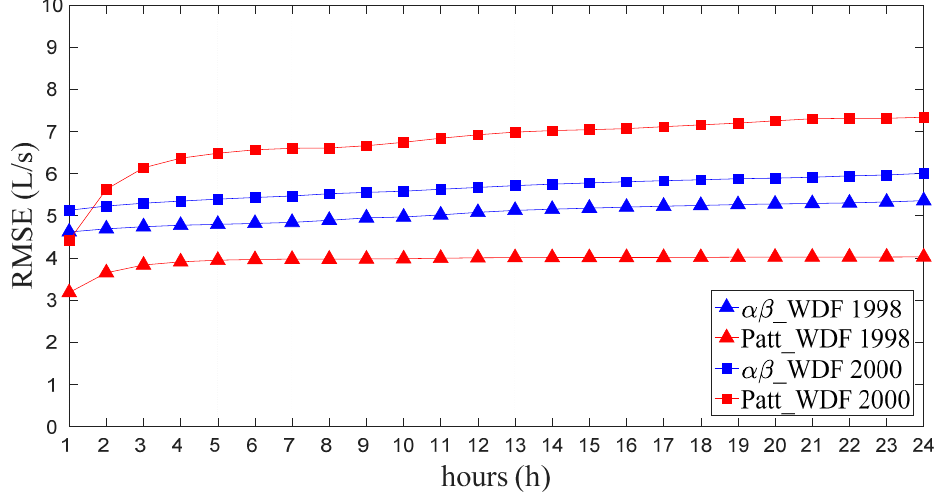
Figure 2. Root Mean Square Error (RMSE) of the αβ _WDF and Patt_WDF models for the years 1998 and 2000 for different forecasting time horizons.